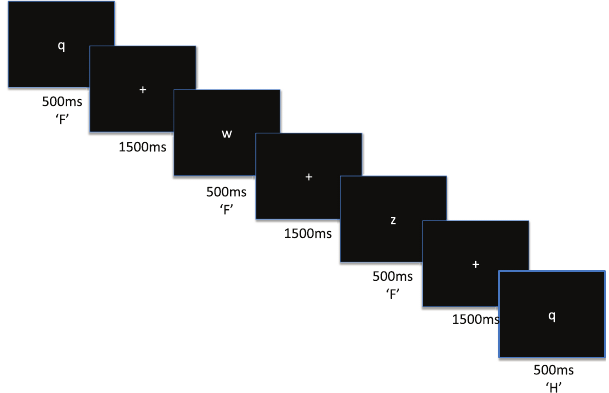
Figure 1. Schema of 3-back task. Stimuli (consonants) were presented centrally for 500 ms and followed by a fixation cross for 1500 ms. Participants were instructed to respond to every stimulus, indicating whether the stimulus matched the letter 3-back (‘H’) or not